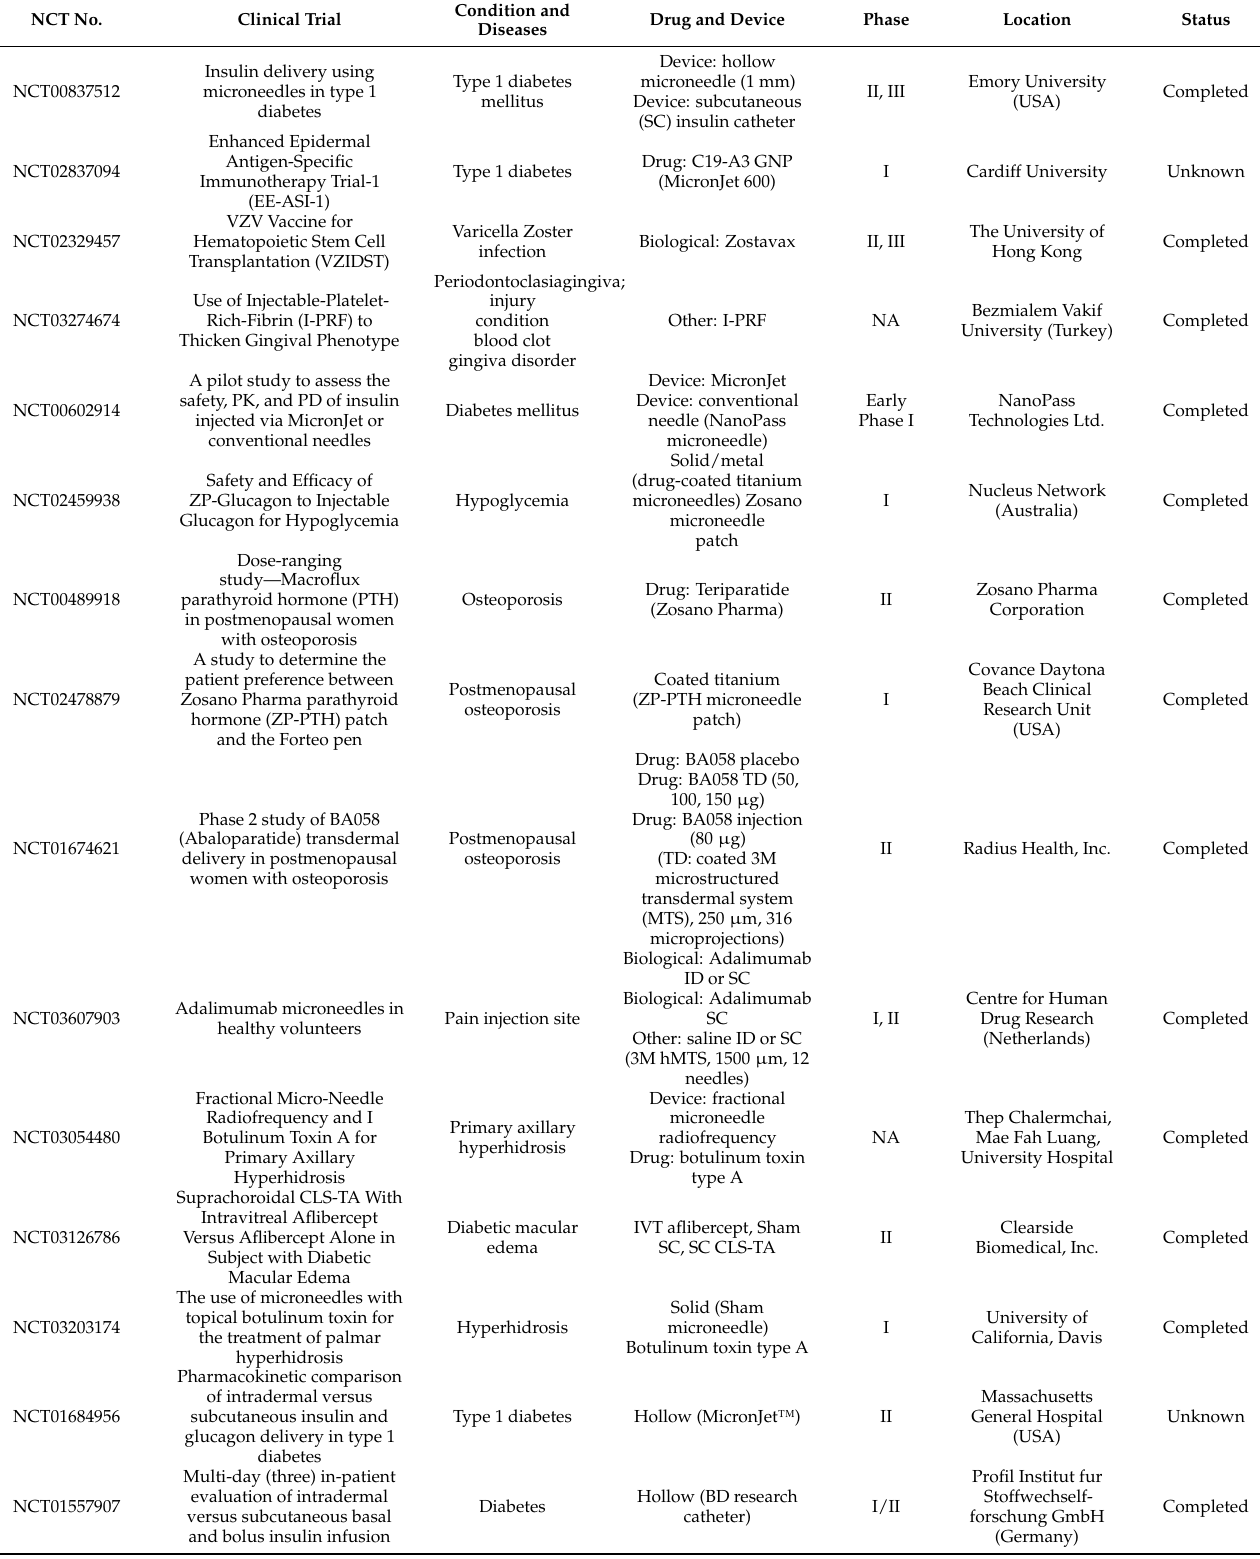
Table 3. Clinical trials of microneedle-mediated delivery of